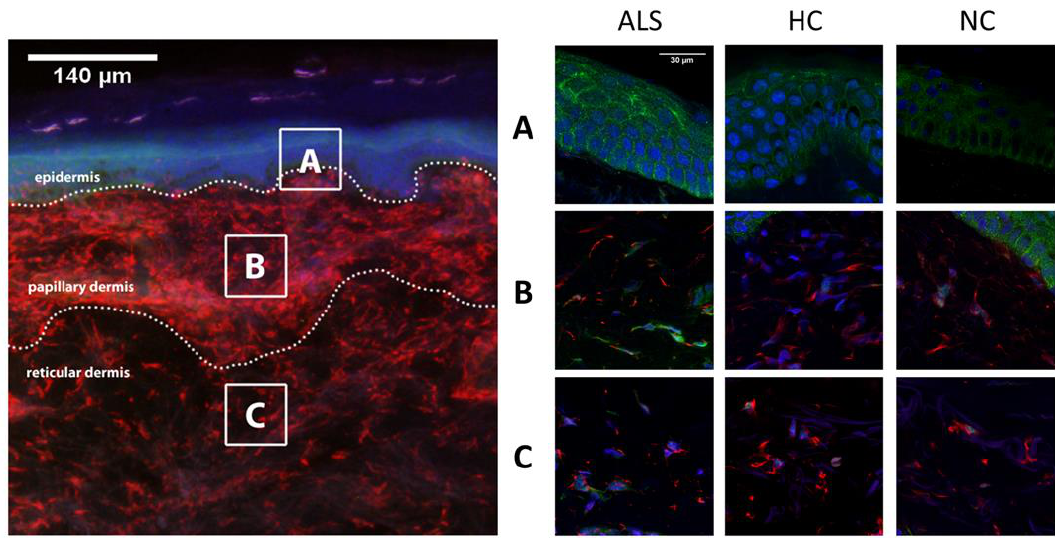
Figure 1. Cytoplasmic TDP-43 immunoreactivity was analyzed in at least two areas of epidermis, papillary and reticular dermis (dotted rectangular area), per case (left panel). In the right panel, representative confocal microscopy images of epidermis ( A ), papillary dermis ( B ) and reticular dermis ( C ) from ALS, HC and NC subjects are shown. TDP-43 was found profusely in epidermis in all cases, although with higher density in the ALS group ( p < 0.001) compared to both HC and NC groups. In the dermis of HC and NC subjects, TDP-43 was mostly seen in the nucleus, whereas cytoplasmic aggregations were more present in ALS cases in papillary and reticular dermis ( p < 0.001). ALS: amyotrophic lateral sclerosis; HC: healthy controls; NC: neurological